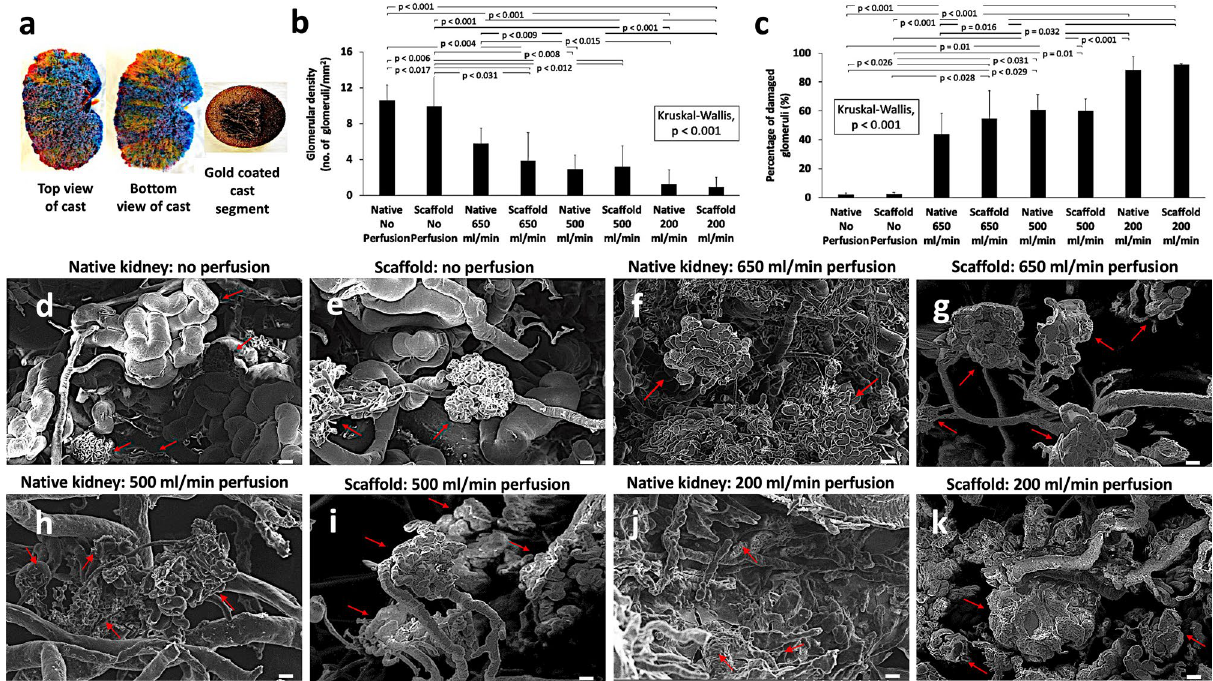
Figure 3. SEM analysis to evaluate the disruption to glomerular microarchitecture in native kidneys and decellularized scaffolds. Two photographs of a polymethylmethacrylate vascular corrosion cast outing the arterial (red), venous (blue), and ureter/pelvis/calyx (yellow) tracks viewed from the top and bottom of the cast, and an arterial portion of the vascular corrosion cast that was sputter-coated with gold for imaging by the SEM ( a ). Comparison of the percentages of damaged glomeruli recorded in native kidneys and decellularized scaffolds subjected to blood perfusion at the various rates of perfusion (b). Comparison of the glomerular densities recorded in native kidneys and decellularized scaffolds that were subjected to blood perfusion at the given perfusion rates ( c ). The p values are based on the Kruskal–Wallis test ( p < 0.001), and pairwise group comparisons are illustrated by means of the Dunn’s post hoc test to highlight the pairs that were significantly different. SEM images of a native kidney ( d ) and decellularized scaffold ( e ) that were not subjected to blood min ( g ), 500 ml/min ( i ), and 200 ml/min ( k ). Red arrows in images ( d ) through ( k ) identify intact or damaged glomerular structures within the kidneys. Scale bars represent 40